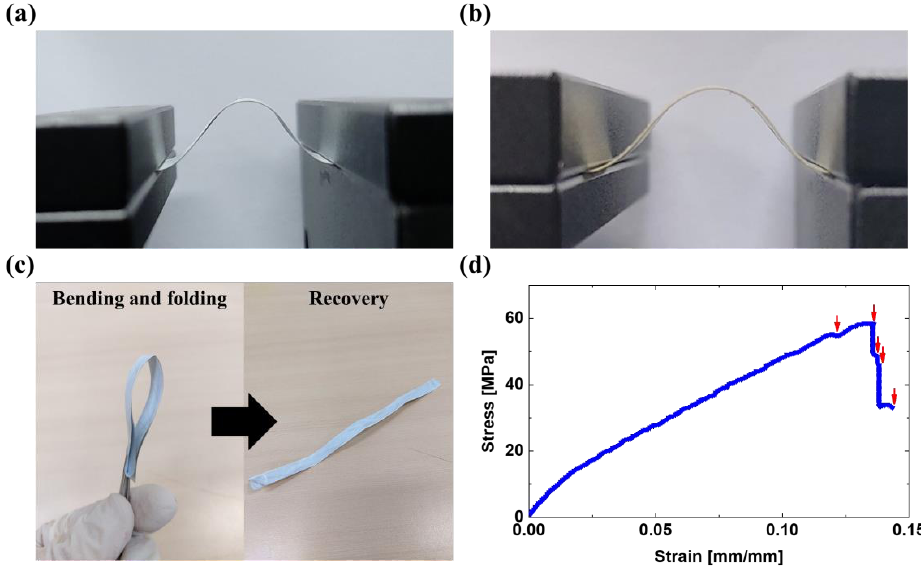
Figure 6. Tests to confirm the mechanical performance of the EMI shielding composites such as E-50 and N-50. Digital images of the cyclic bending tests for ( a ) E-50 and ( b ) N-50 using a custom motorized stage. ( c ) Digital image of the flexibility test of E-50. After the bending and flexibility tests of E-50 and N-50, any detachment at the interfaces between Ag and nylon 66 layers was not observed. ( d ) Stress-strain curve of E-50. The red arrows indicate the strain values at which each layer was fractured one by one.